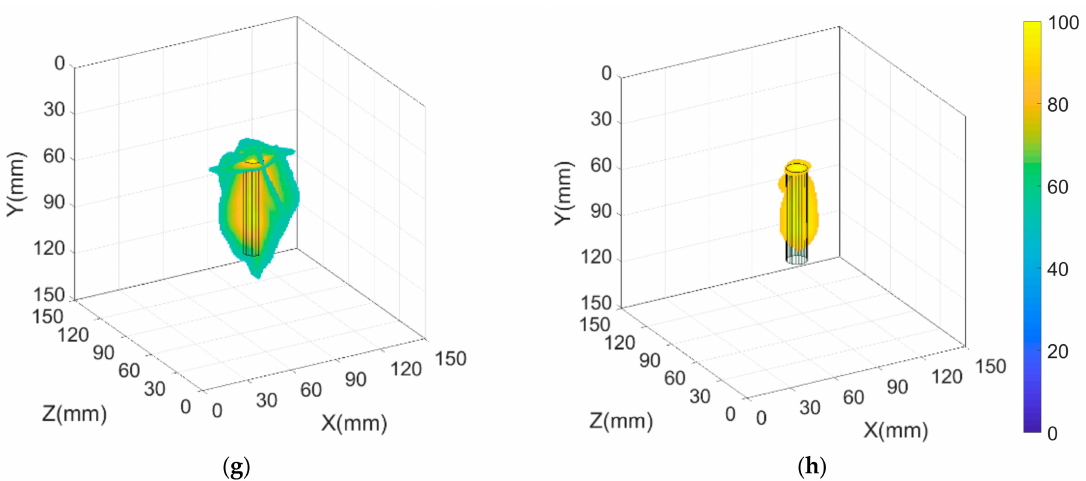
Figure 4. 3D reconstruction of the defect by combining the resulting SAFT images from the three faces and superimposing the actual cylindrical shape of the defect. ( a ) Isometric view resulting from face 1 (front view / X 1 Y 1 ) scan area inspection by applying a reject threshold for data with an intensity below 65%; ( b ) Front view resulting from face 1 scan area inspection by applying a reject threshold for data with intensity below 65%; ( c ) Isometric view resulting from face 2 (Side view / X 2 Y 2 ) scan area inspection by applying a reject threshold for data with an intensity below 65%; ( d ) Side view resulting from face 2 scan area inspection by applying a reject threshold for data with an intensity below 65%; ( e ) Isometric view resulting from face 3 (Top view / X 3 Y 3 ) scan area inspection by applying a reject threshold for data with an intensity below 65%; ( f ) Top view resulting from face 3 scan area inspection by applying a reject threshold for data with an intensity below 65%; ( g ) Isometric view resulting from the 3d reconstruction by applying a reject threshold for data with an intensity below 65%; ( h ) isometric view by applying a stricter reject threshold for data with an intensity below 85%. (Color map at bottom right applies to all